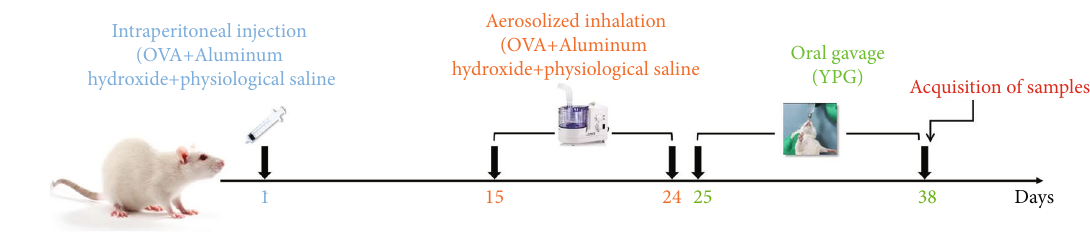
Figure 1: Rat model of bronchial asthma and treatment with